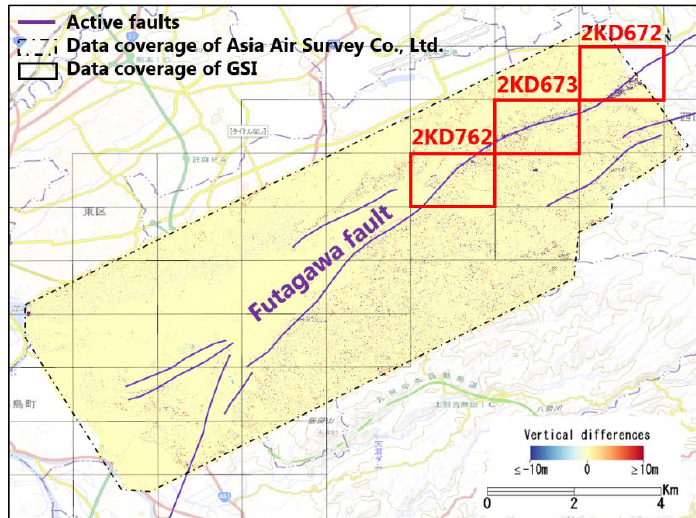
Figure 2. Enlarged area of the white frame in Figure 1a. The coverage of the DSMs acquired by Asia Air Survey Co., Ltd. is enclosed by the dashed line, and the coverage of the DSMs acquired by GSI is shown in the black gridlines. The vertical differences between the pre- and post-event DSMs acquired by Asia Air Survey Co., Ltd., after removing the influence of the crustal displacements, also overlaps the base map. Our target areas are shown with red frames.